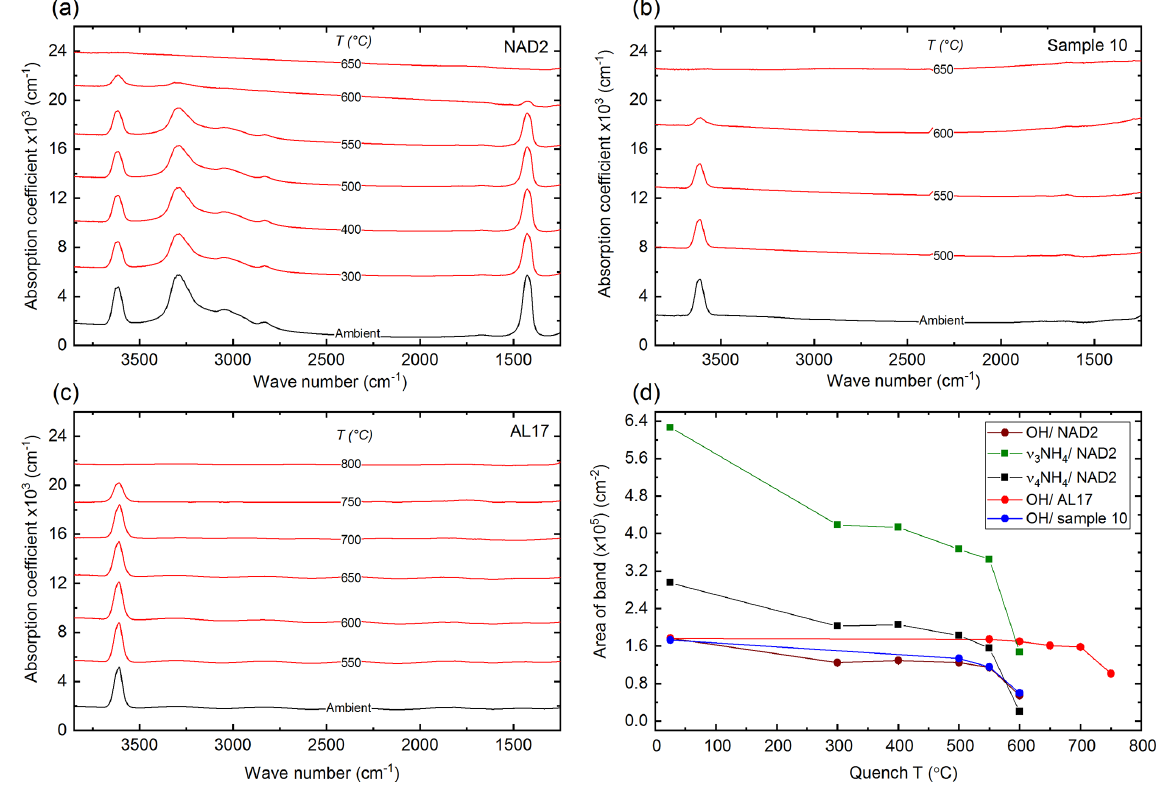
Figure 5. Calculated absorption coefficients in the 3850–1250cm − 1 range of the quenched samples NAD2 (a) , sample 10 (b) and AL17 (c) after 24h of annealing at each T . Spectra are vertically offset for clarity. (d) Area of the OH band of the three different samples and the − ν NH + 3 , ν 4 of NAD2 vs. quench T . Lines connect the points only as a guide to the eye. The error bars are smaller than the 4